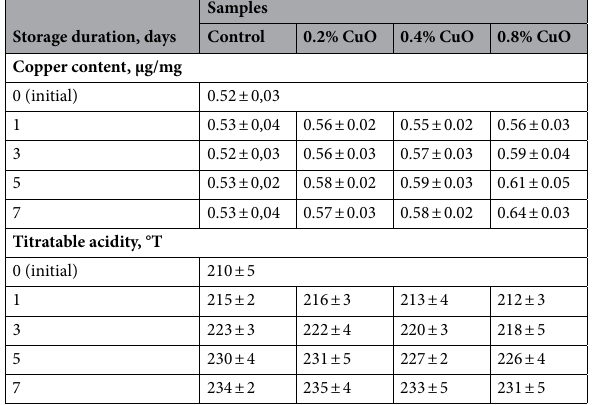
Table 4. Dynamics of changes in titratable acidity and copper content of cheese samples during storage.